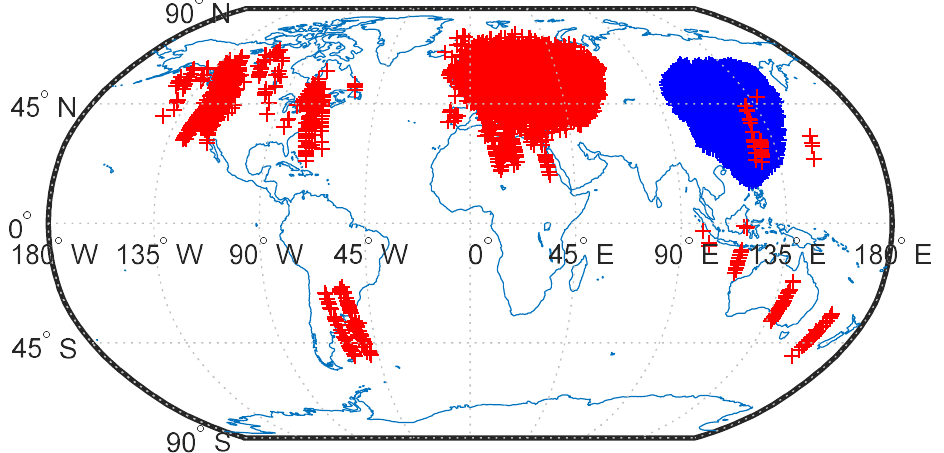
Figure 4. Broadcast GPS positions through beacons (blue: received at SNUGLITE ground station; red: received in other ground stations).